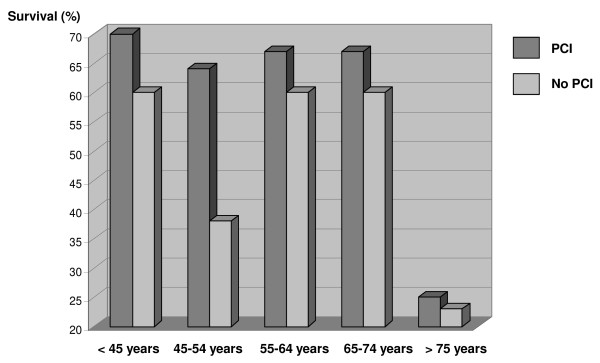
Survival according to whether a percutaneous coronary intervention (PCI) was performed in the different study groups.